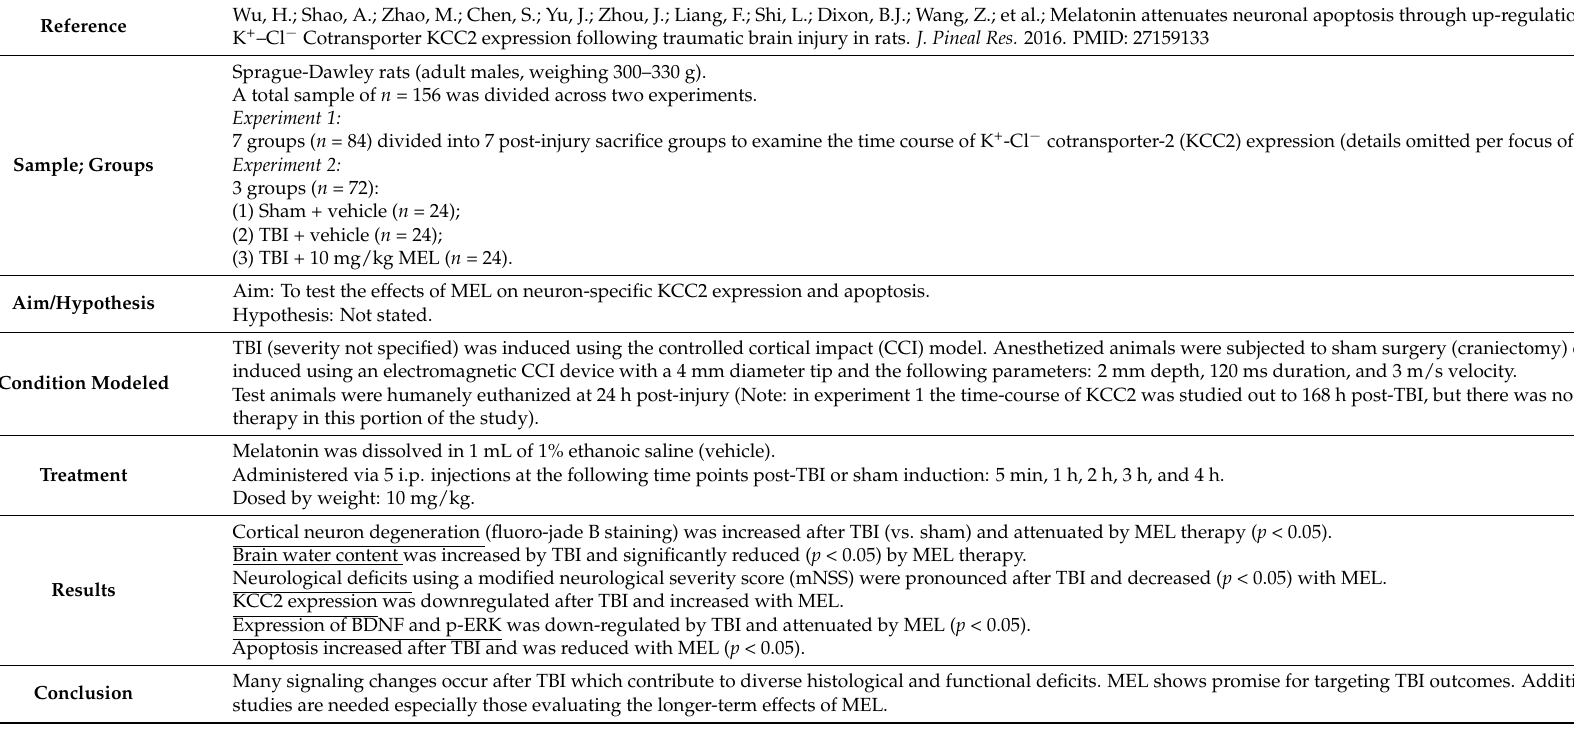
Table A22. Wu et al. (2016) Study